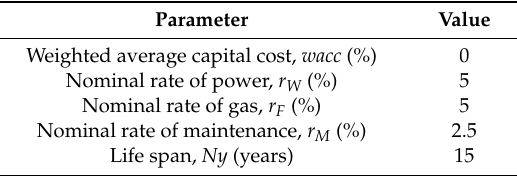
Table 6. Assumed economic